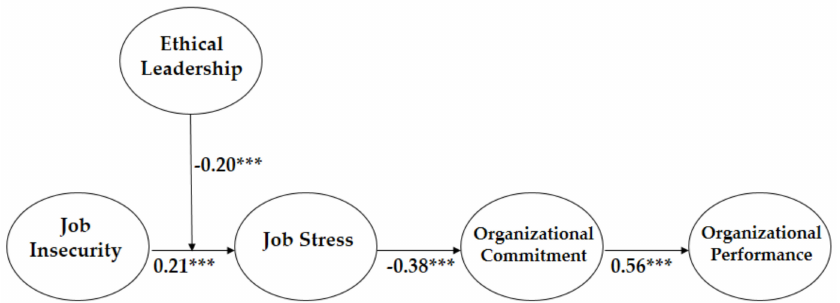
Figure 2. The Result of Coe ffi cient Values of our Research Model. *** p < 0.001.